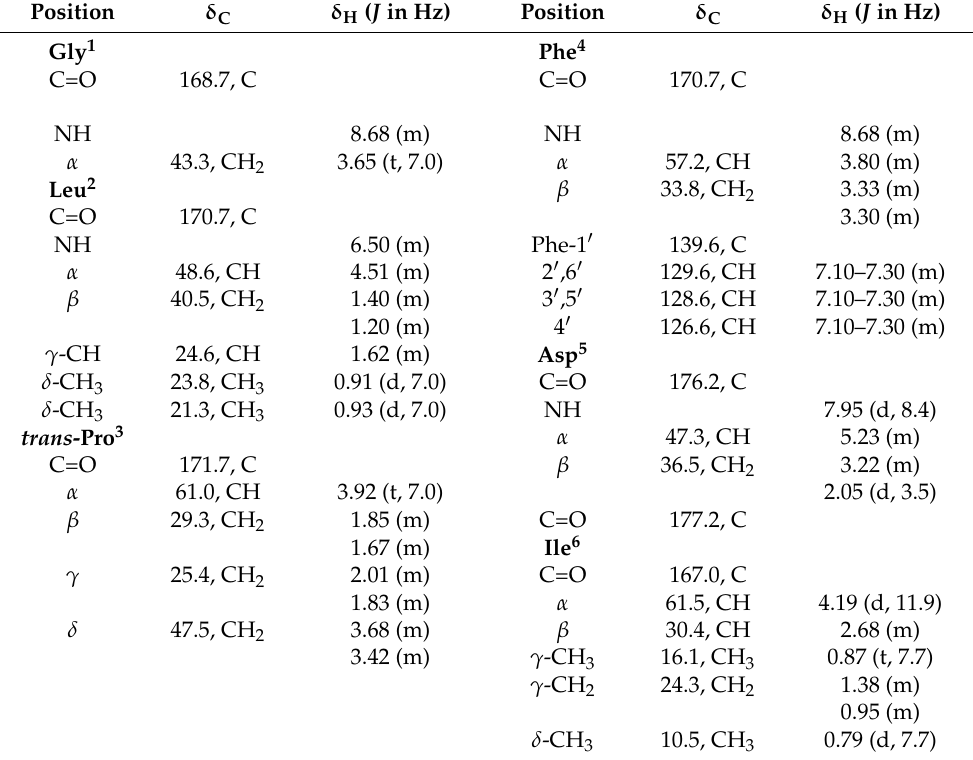
Table 2. 1 H and 13 C NMR data for dianthiamide B ( 2 ) (DMSO- d 6 , 700 MHz, d in ppm, J in